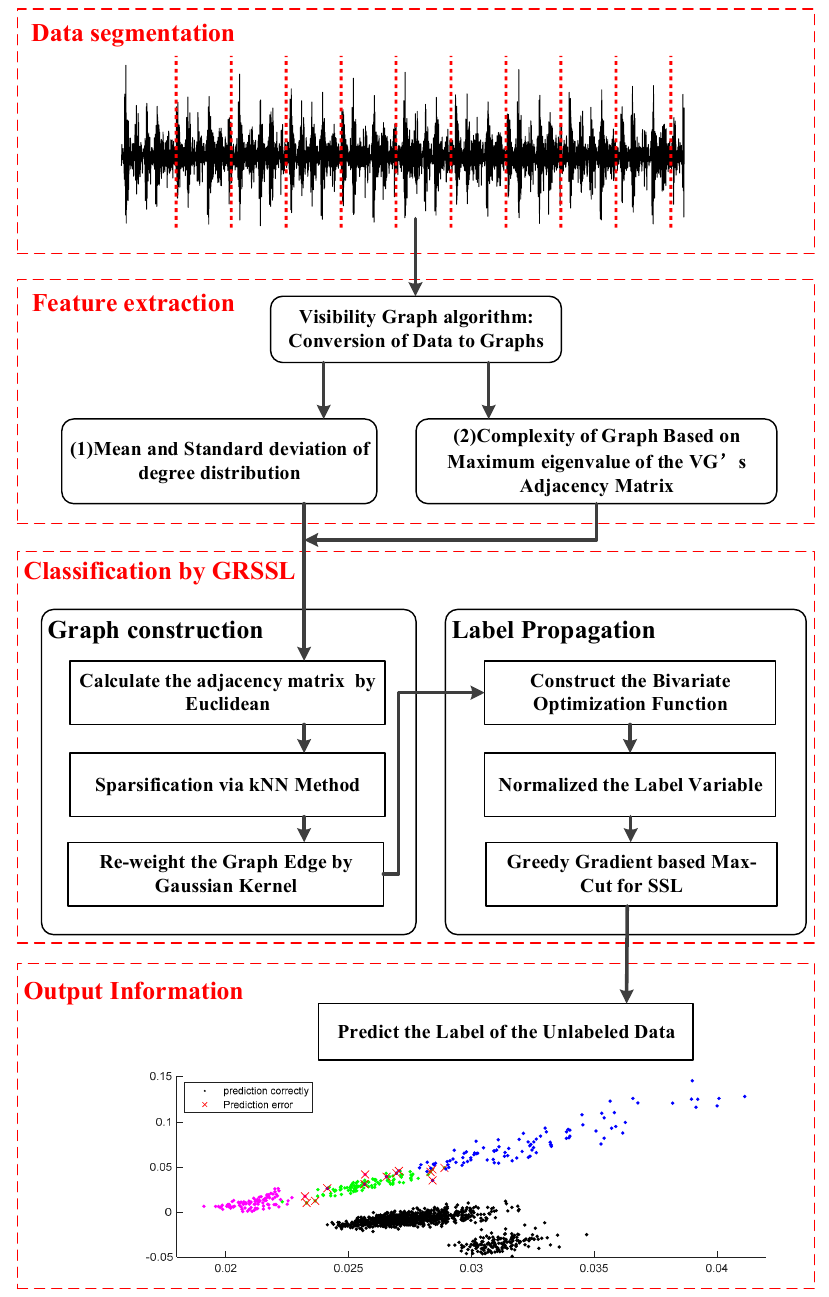
Figure 1. The overall scheme of proposed fault diagnosis method.